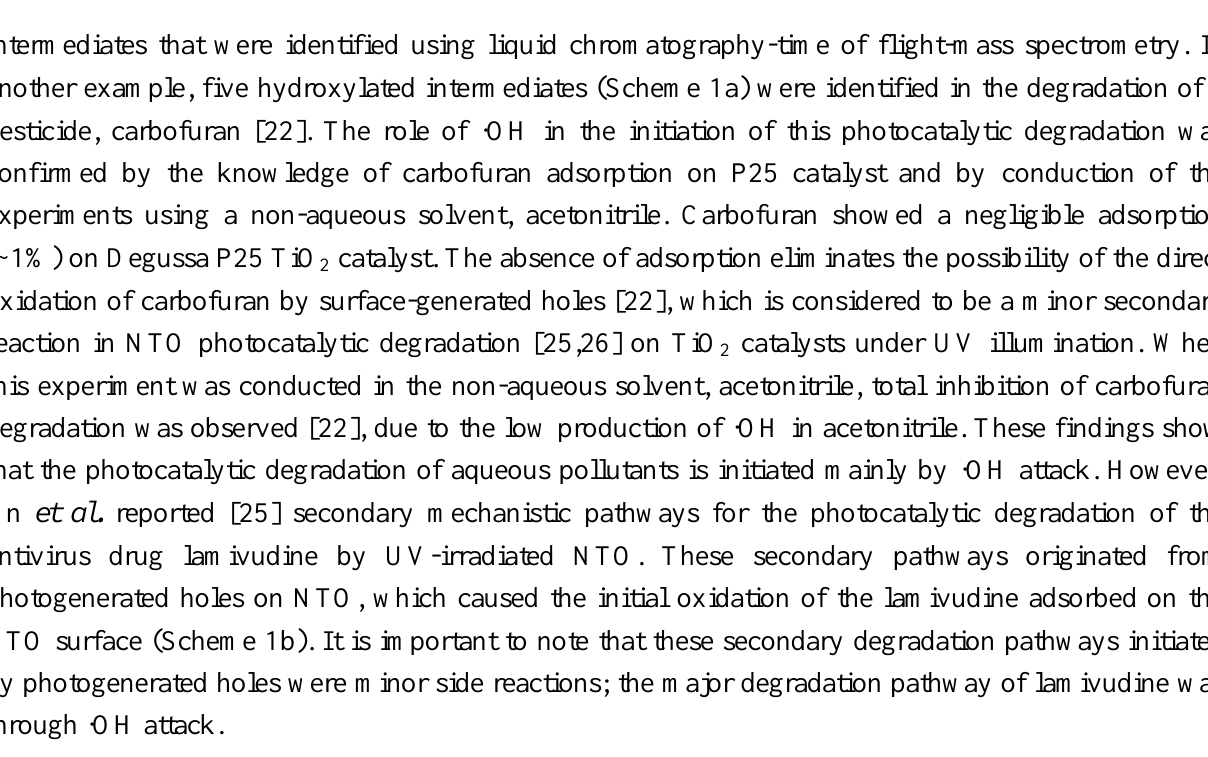
Table 1. Recent examples of pollutants photocatalytically degraded by NTO.